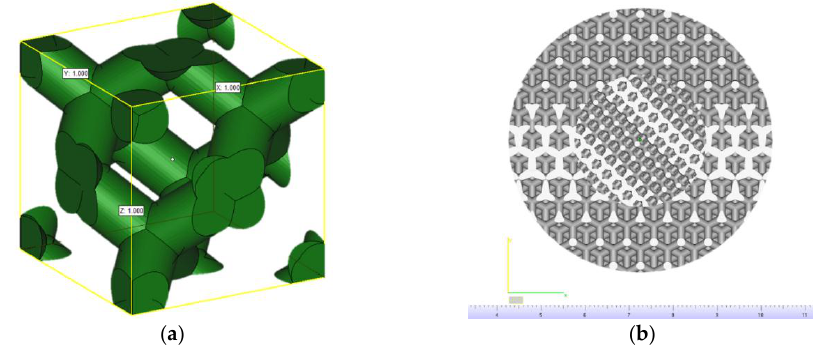
Figure 1. Diamond elemental structure (30% relative density) x = y = z = 1.0 mm ( a ); 3D model of bimodal scaffold composed of diamond structures of different sizes (x = y = z = 0.47 mm—pores 200 µm; x = y = z = 0.87 mm—pores 500 µm)—top view ( b ).